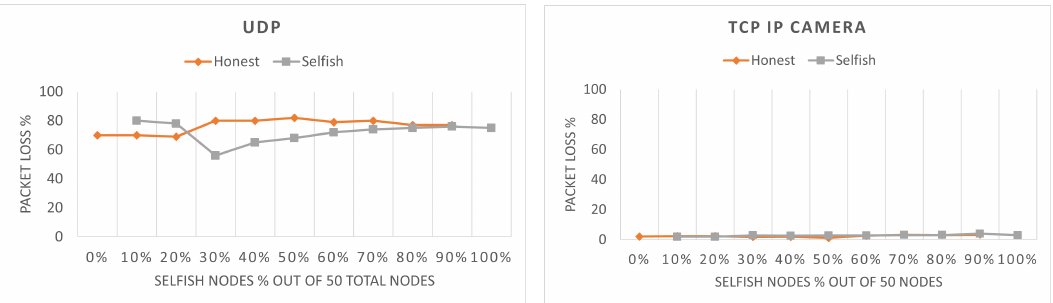
Figure 7. Packet loss of selfish and honest stations in 60 s for different percentages of selfish stations in a network with two RAW